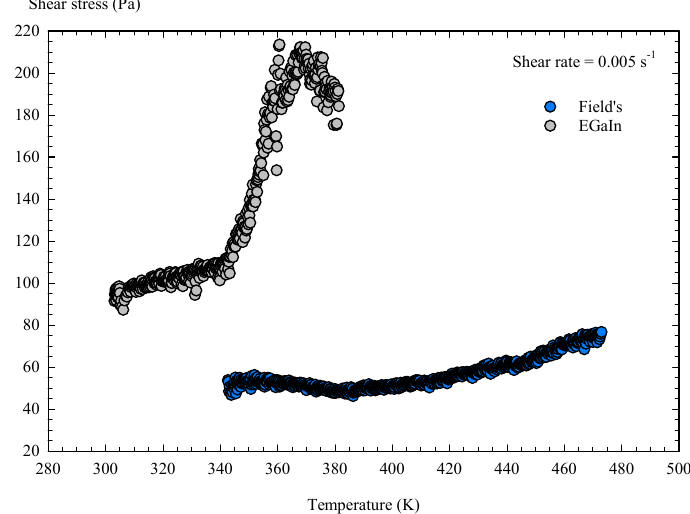
Figure 12. Results of the flow temperature ramp